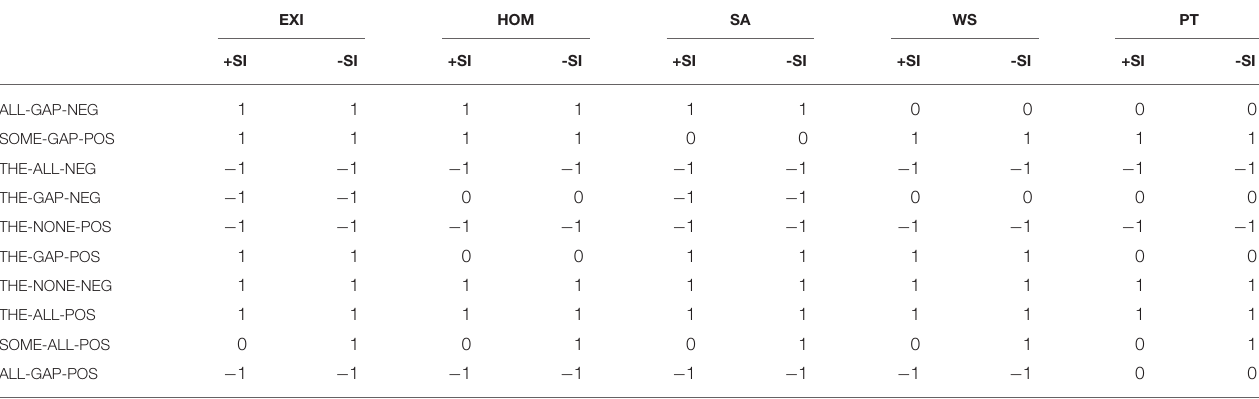
TABLE 8 | Predicted responses to each condition ([determiner]-[context]-[polarity]) for each of the possible